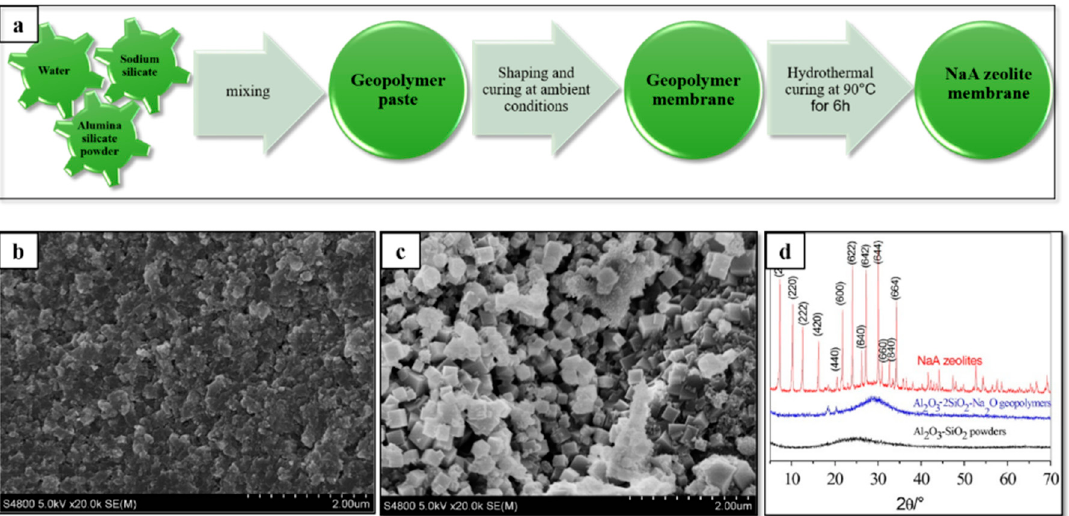
Figure 9. Geopolymer membranes from cheaply available and non-hazardous materials. Hydrothermal curing of geopolymer produces self-supporting zeolite membranes. ( a ) fabrication route; ( b ) cross-section of geopolymer membrane; ( c ) cross-section of zeolite membrane obtained from geopolymer; ( d ) XRD patterns confirming the formation of zeolite membranes (adapted from ref. [167] with permission from Elsevier).